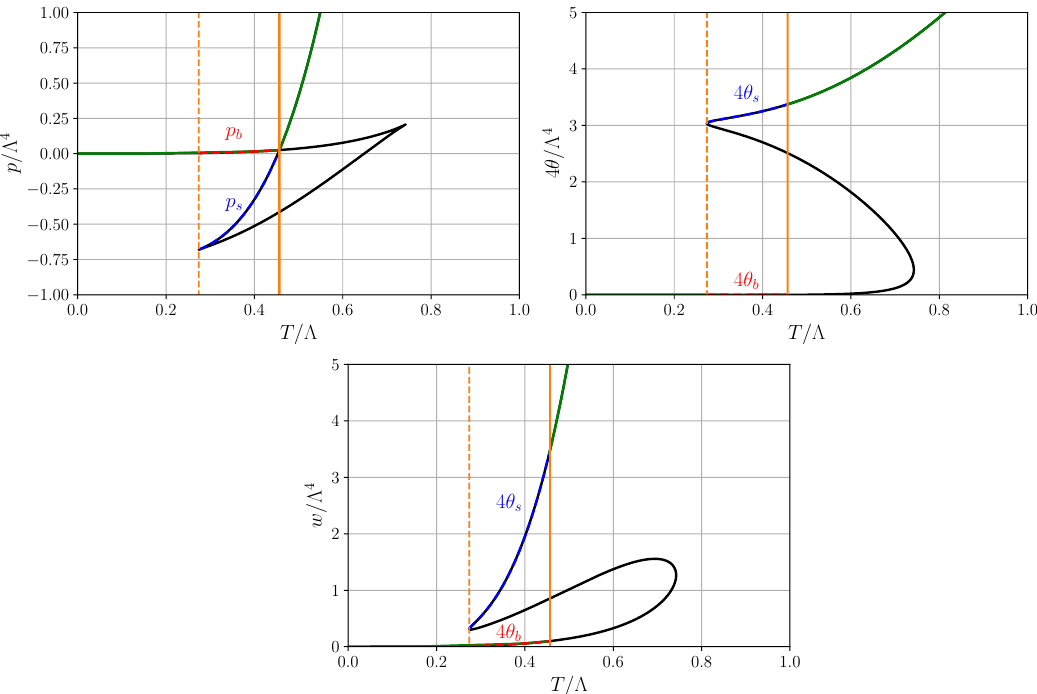
Figure 4 . Pressure, trace of the energy-momentum tensor, and enthalpy density for φ Q = 10 . 0 and φ M = 0 . 7 , with the different branches labeled. The green line shows the stable phase, the solid yellow line shows T c , and the dashed yellow line shows T 1